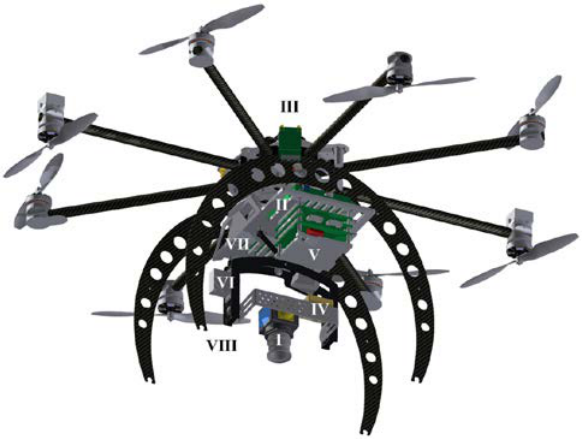
Figure 2: CAD model of mounted MACS-Micro